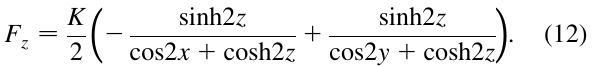
ffiffiffi ffiffiffi p p x ¼ y ¼ (cid:3) 150 . 2 2 4 155 : 6